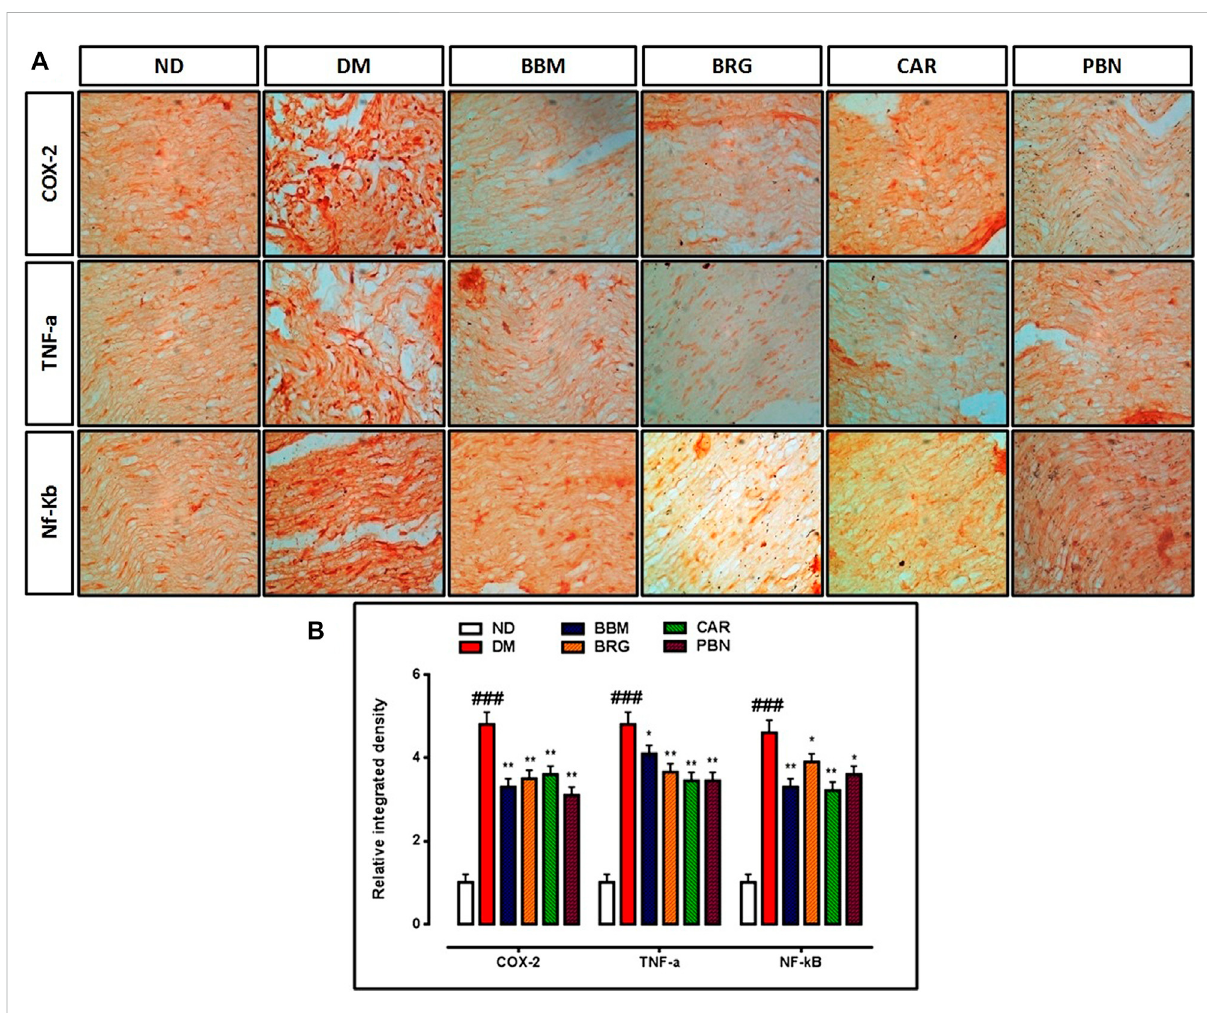
FIGURE 8 (A,B) represent the effect of berbamine, bergapten, carveol, and pregabalin on protein expression of cyclooxygenase-2 (COX-2), tumor necrosis factor- α (TNF- α ), and nuclear factor kappa B (NF- κ b) in the sciatic nerve. Images were analyzed by ImageJ software Bar 50 µm, magni fi cation 40x. GraphPad prism is used to plot the graph and probability value was calculated by GraphPad instate. Data expressed as mean ± SEM, ( n = 6). One way ANOVA followed by posthoc Tukey test. ### p < 0.001 vs. non-diabetic (ND),* p < 0.05 and ** p < 0.01 vs. streptozotocin- induced diabetic neuropathy